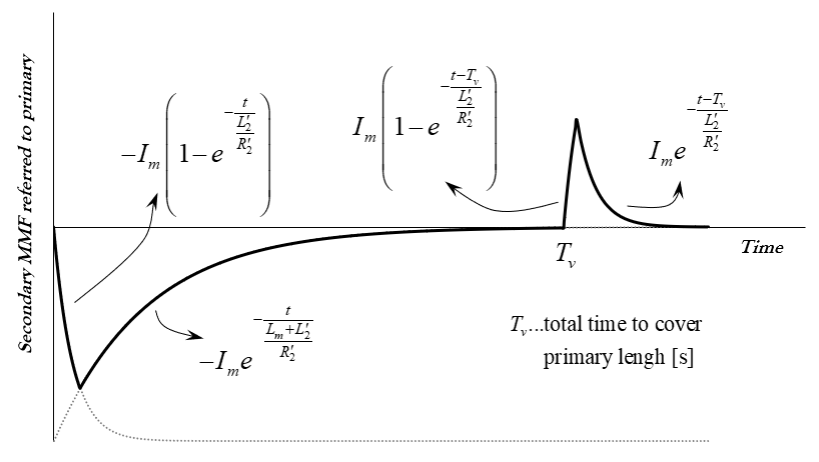
Figure 2. Secondary mmf reaction behavior through time.